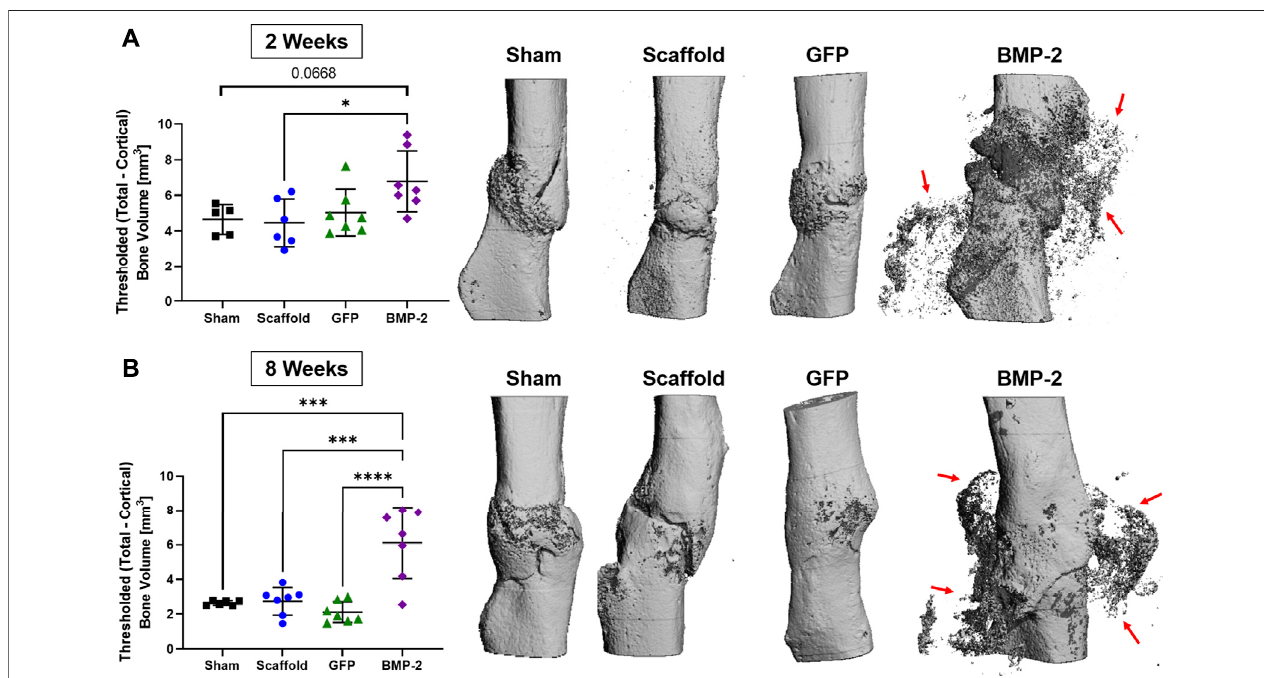
FIGURE4| Exvivo micro-CTanalysisofnon-unionstreated withsham control, scaffoldonly,GFP+ cellularized scaffolds, and BMP-2+cellularized scaffolds at (A) 2 and (B) 8 weeks after repair. The callus bone volume is the threshold total bone — cortical bone. At 2 weeks, the BMP-2+ scaffolds had signi fi cantly more callus bone volumethan(acellular)thescaffoldonly( p < 0.05)andtrendedhigherthantheshamcontrol( p < 0.0668).At8 weeks,theBMP-2+scaffoldshadsigni fi cantlymorecallus bone volume than all the other groups ( p < 0.001). Three-dimensional reconstructions demonstrate that fracture lines are still present in the sham and scaffold groupsatboth2and8 weeks,whereastheGFPandBMP-2groupsexhibitedincreasedbridgingandremodelingafter8 weeks.Finally,bothtimepointsexhibitedahigh mineral content surrounding the non-union site of the BMP-2+ groups (red